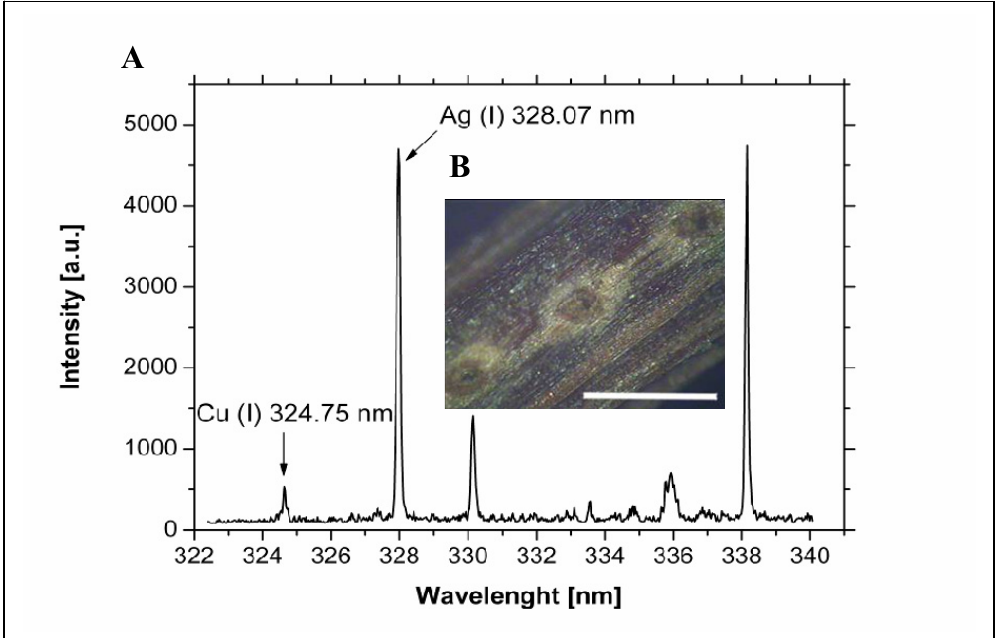
Figure 6. The typical LIBS spectrum with the 328.07 nm Ag(I) and 324.75 nm Cu(I) lines used in the analysis ( A ) together with the image of three ablation craters ( B ). The bar on B has a length of 500 μ